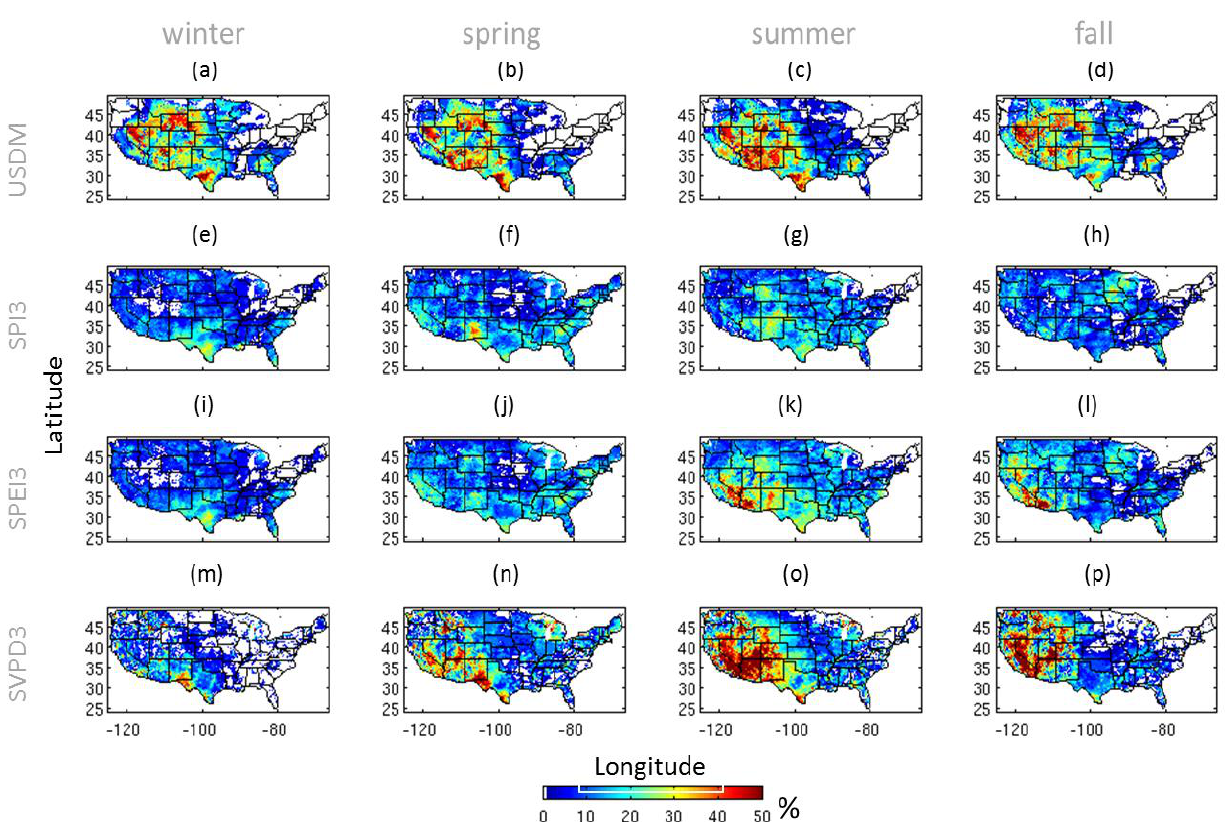
Figure 1. Seasonal maps of probability of severe drought identified based on ( a – d ) USDM drought categories equal or greater than 2, ( e – h ) SPI3 < −1.25, ( i – l ) SPEI3 < −1.25, and ( m – p ) SVPD3 > 1.25. Columns, from left to right, the seasons are winter (DJF), spring (MAM), summer (JJA), and fall (SON). The probabilities are calculated using the latest 11 years (2003–2013), but for calculation of standardized indices the entire record (1900–2013) is